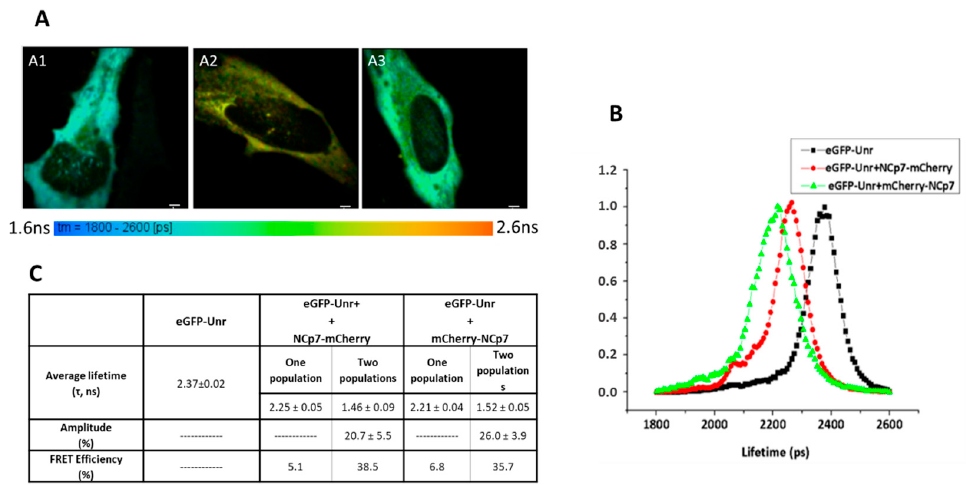
Figure 6. Unr/NCp7 interaction monitored by FRET-FLIM. HeLa cells were transfected with DNA constructs encoding eGFP-Unr ( A1 ) and NCp7-mCherry ( A2 ) or mCherry-NCp7 ( A3 ). Live cells were imaged 24 h post-transfection. The eGFP fluorescence lifetime was determined using a single- exponential model and converted into a color code ranging from blue (1.6 ns) to red (2.4 ns). ( B ) Distributions of τ values expressed in ps for cells expressing eGFP-Unr alone (black); eGFP-Unr with NCp7-mCherry (red) or eGFP-Unr with mCherry-NCp7 (green). ( C ) Fluorescence lifetimes of eGFP-Unr, in the presence of NCp7-mCherry or mCherry-NCp7, analyzed by one or two populations analysis. The lifetimes are expressed as mean ± SEM for about 20 cells. For the two-population analysis, the long-lived lifetime was fixed to 2.37 ns, and the shorter lifetime as well as its amplitude were determined and expressed as mean ± SEM for about 20 cells. The lifetime of eGFP-Unr expressed alone was obtained through a one-population analysis. The bar scale represents 10 μ m.